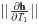
Comparison of sensitivity (top panel) and orthogonality sin ϕ (bottom panel) of T1 estimation for the new TSI sequence (blue), the original TSI sequence (cyan), and the SPGR sequence (black).The norm of T1 sensitivity ||∂h∂T1|| is calculated as the Euclidean norm of the derivative of the signal weighting vector with respect to T1. Increasing the norm of the sensitivity will increase the impact of small changes in T1 on the overall signal weighting vector h. sin ϕ is the orthogonality term defined in Fig 1. The more orthogonal these vectors are, the easier it becomes to ascribe changes in the observed signal to M0 or T1 unambiguously. The top panel shows the new TSI sequence has the best sensitivity among the three sequences and SPGR has very poor sensitivity for T1 estimation. The bottom panel shows the TSI-family sequences have greater orthogonality (above 0.7) than the SPGR sequence (equal to 0.58) for the tested T1 range.